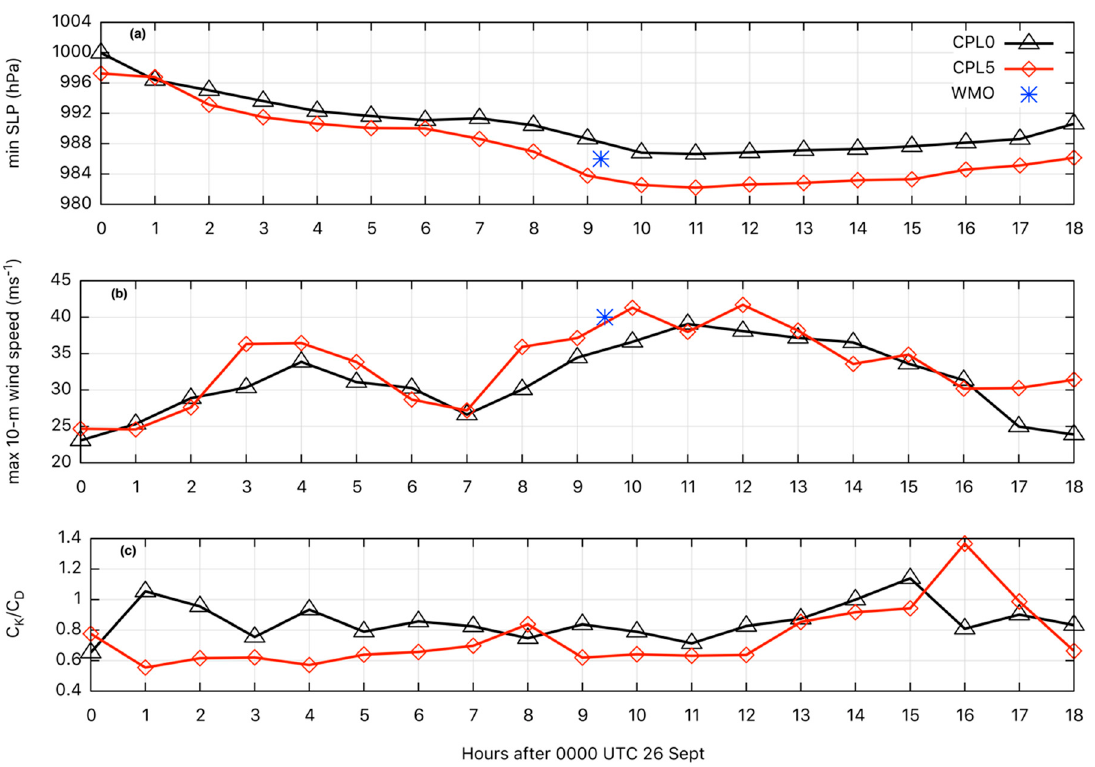
Figure 9. Time series of the minimum sea-level pressure ( a ); maximum 10-m winds ( b ) and ( c ) ratio between moist enthalpy ( C k ) and drag coefficient for momentum ( C D ). The minimum sea level pressure measured in Nardò station (986 hPa at 0915 UTC) and the maximum wind speed recorded in Galatina station (WMO station) (40 m/s at 0930 UTC) are also shown (blue asterisks) respectively in ( a , b ) (data from [6]) both taken along the cyclone track.